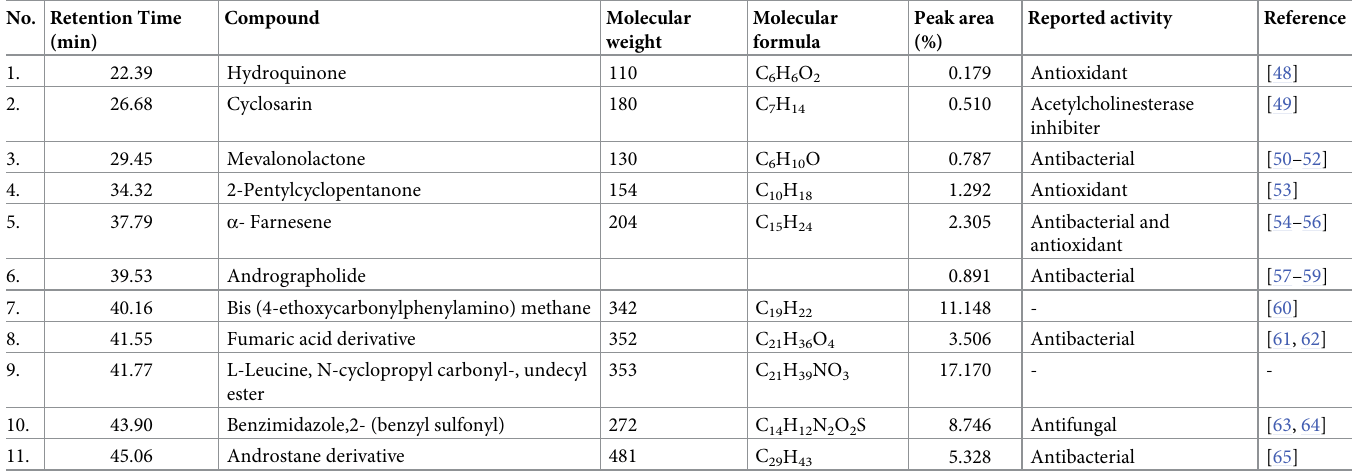
Table 1. List of major compounds identified from IBSD-19 fungal extract.